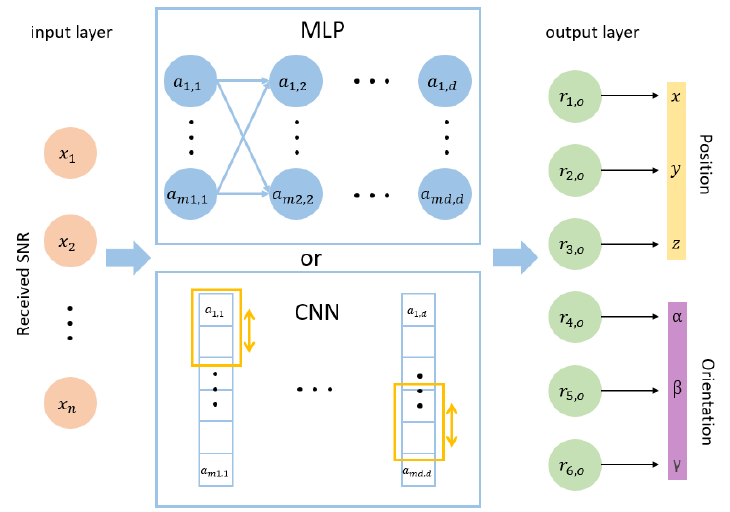
Figure 16. The structure of the proposed position and orientation estimation